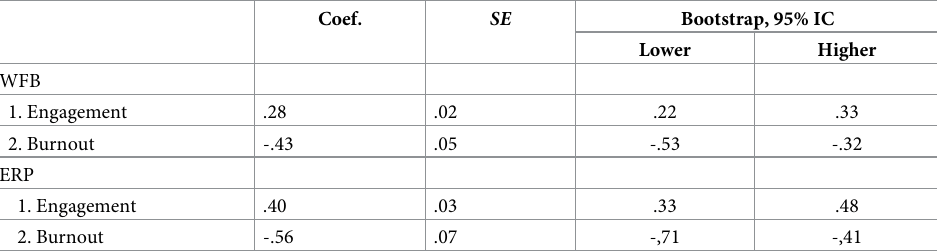
Table 4. Confidence intervals for the indirect effects of the interpersonal justice scheme in the WFB and ERP, using the bootstrapping procedure.